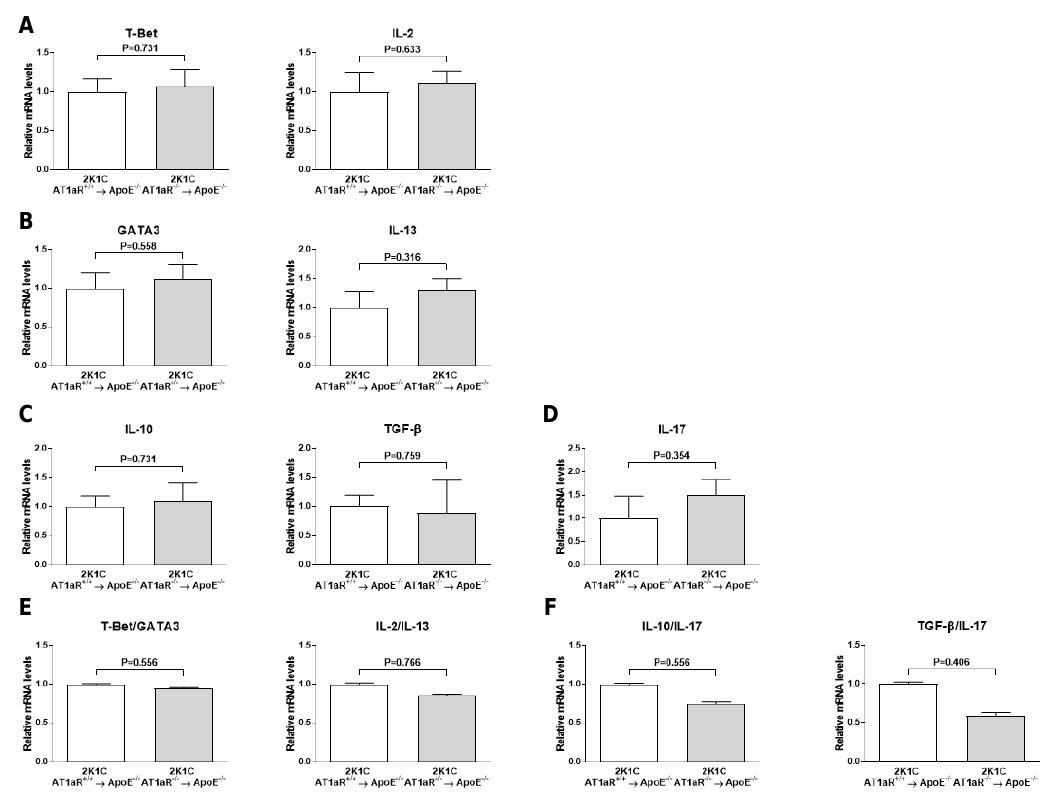
Figure 7. Effect of AT1aR deficiency in BM-derived cells on systemic expression of CD4 + T cells phenotype markers. mRNA levels of pro-inflammatory Th1 markers T-bet and IL-2 ( A ), anti-inflammatory Th2 markers GATA3 and IL-13 ( B ), Treg markers IL-10 and TGF- β ( C ), and Th17 marker IL-17 ( D ). mRNA levels were determined in splenic tissue by real-time RT-PCR analysis. Data were normalized to 36B4 and expressed as fold change over controls which were set at 1. Error bars are the SEM of the ∆ CT values. Quantification of T-bet to GATA3 and IL-2 to IL-13 ratios (Th1/Th2 balance markers) ( E ), and of IL-10 to IL-17 and TGF- β to IL-17 ratios (Treg/Th17 balance markers) ( F ). n = 10–12 animals per group.